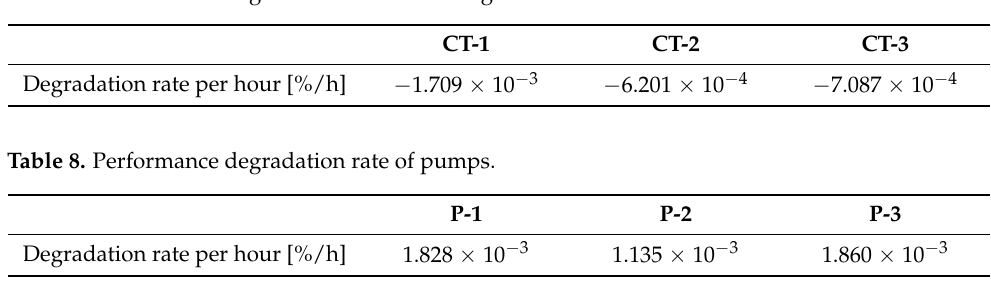
Table 7. Performance degradation rate of cooling towers.